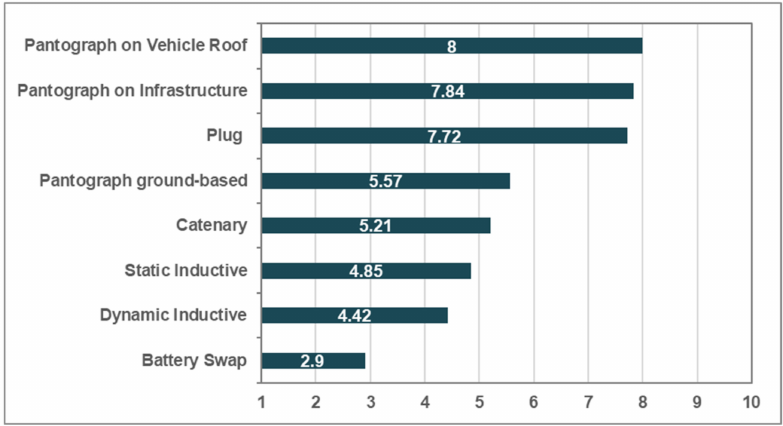
Figure 7. Rating the potential of different charging technologies (1 = low potential and 10 = high